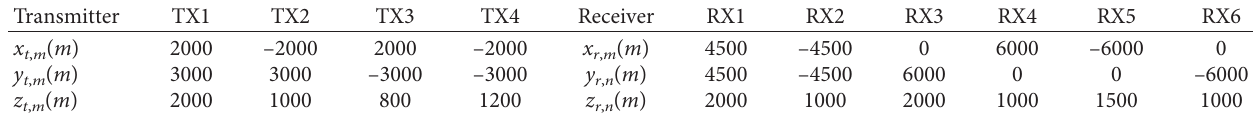
Table 1: Positions of the transmit/receive antennas.